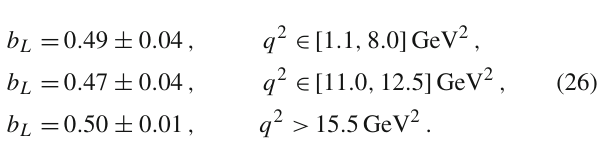
Fig. 2 Predictions for the parameters b V (left) and b L (right) in small q 2 bins in the low q 2 region (see main text). Numerical results for the different bins and their correlation matrix are given in Appendix 1